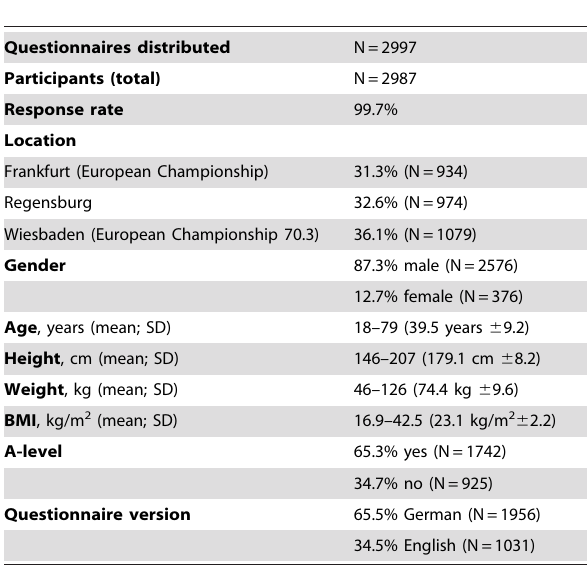
Table 4. Biographical data of the participants.